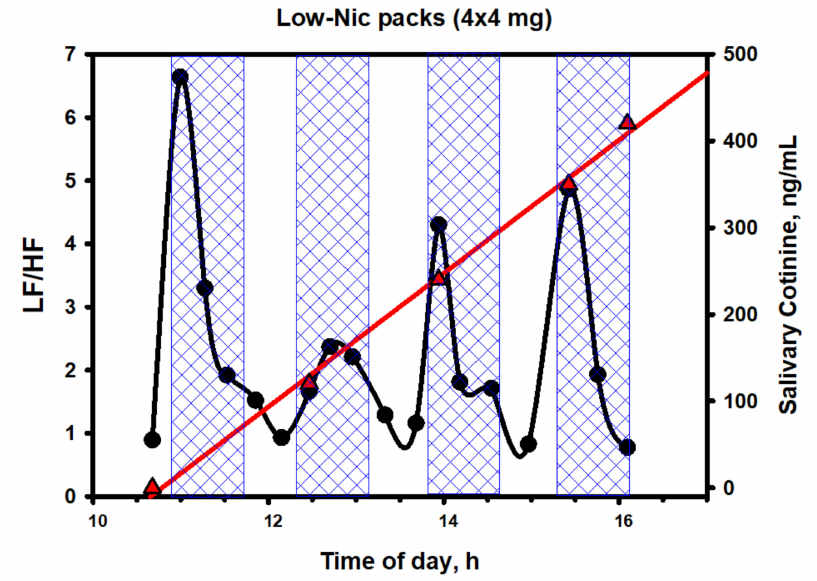
Figure 11. Dynamics of cotinine in saliva (red straight line with triangles) and the LF/HF ratio (black line with circles) during the period of nic-pack testing (4 packs with 4 mg of nicotine). Periods of fixation of packs in the oral cavity are marked with blue-shaded areas.